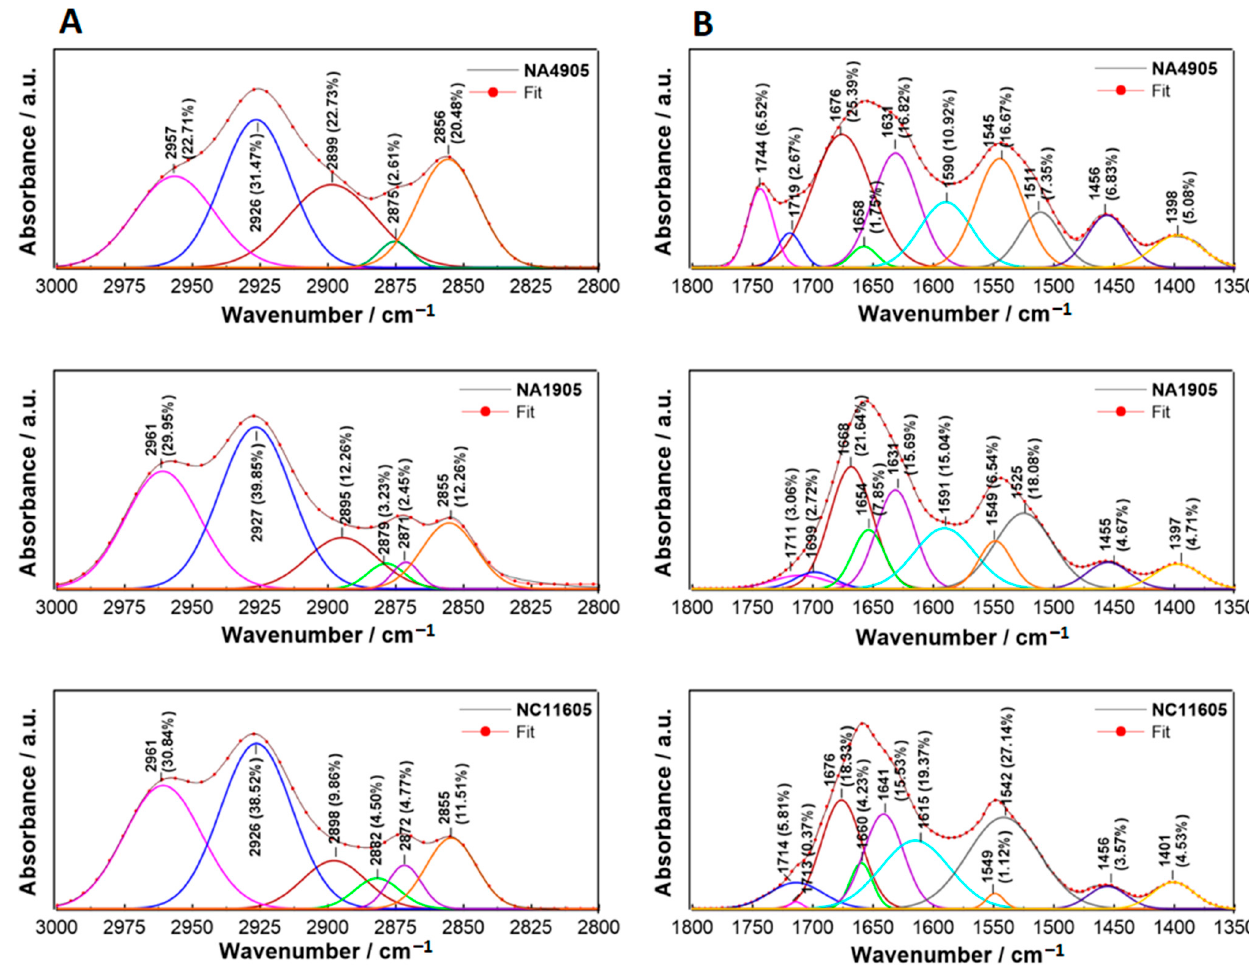
Figure 5. Deconvolution of the lipid (3000–2800 cm − 1 , ( A )) and protein/lipid (1800–1350 cm − 1 , ( B )) regions of NA4905, NA1905, and NC11605 samples into separate subcomponents involving Lorentz/Gauss combination peak fitting function. Each band was allocated a maximum and its percentage contribution to the total surface area.